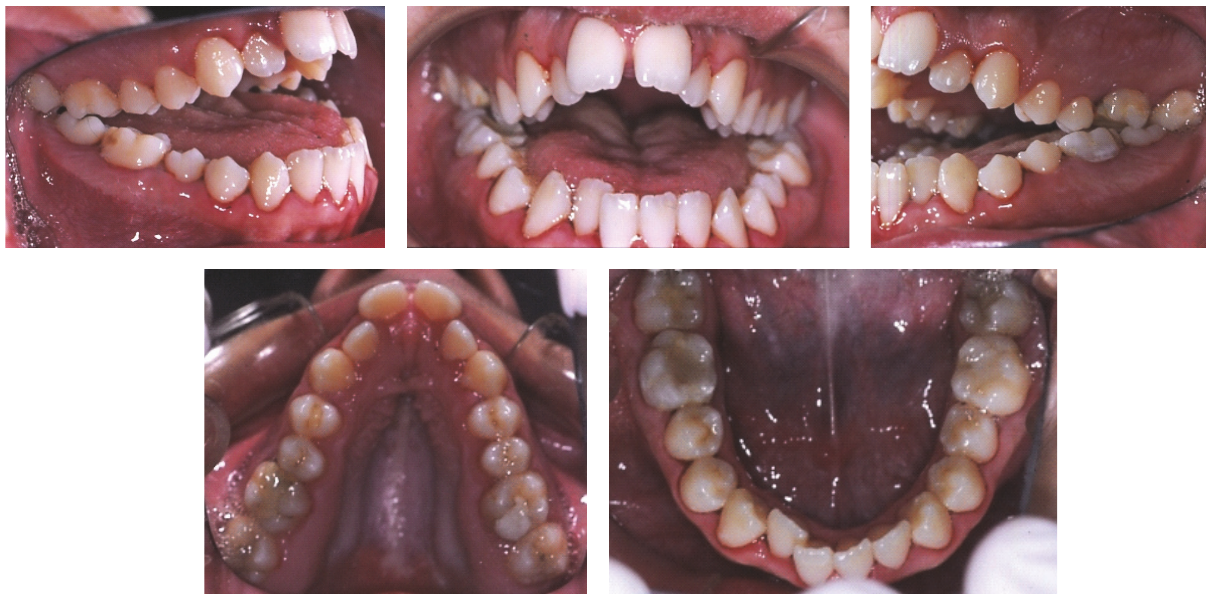
Figure 2: Intraoral photographs at the time of the first visit.